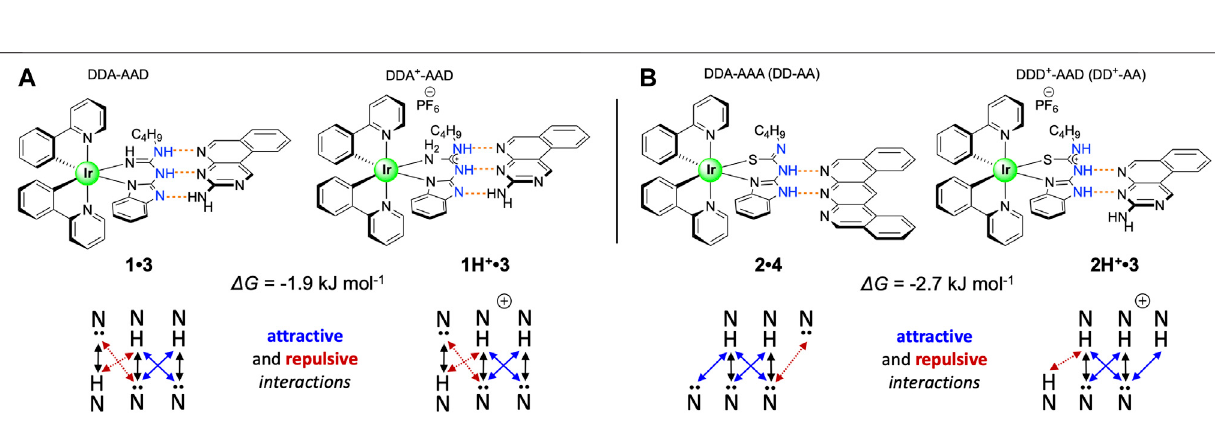
Frontiers in Chemistry |